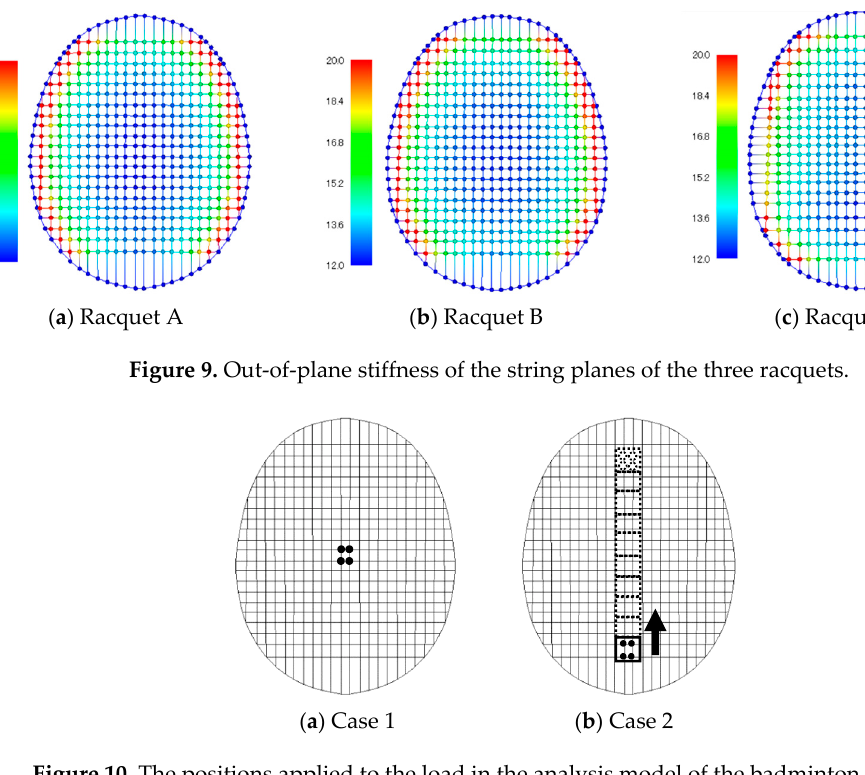
Figure 10. The positions applied to the load in the analysis model of the badminton racquet.